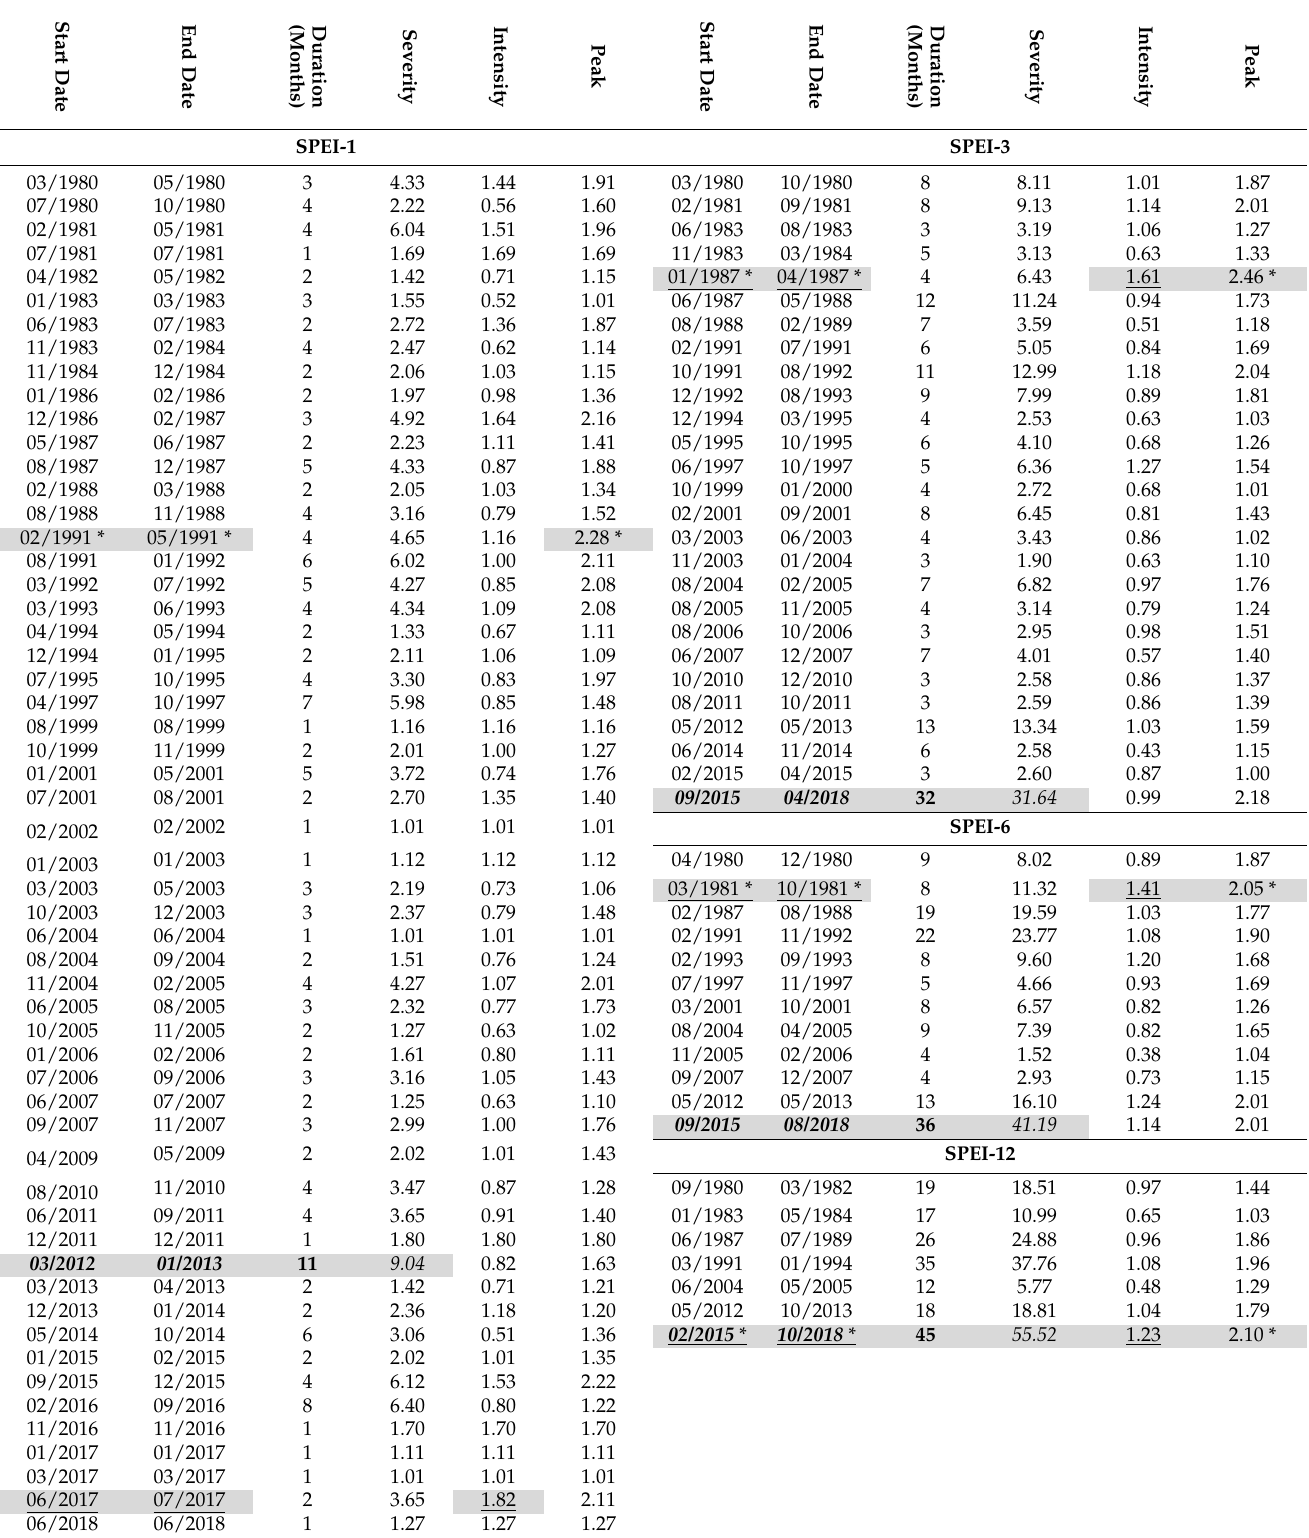
Table 2. Dry events at SPEI-1, -3, -6, and -12 over ESA for 1980–2018. For each scale, the events with a maximum in duration, severity, intensity, and peak are in gray and bold, italic, underline, and with